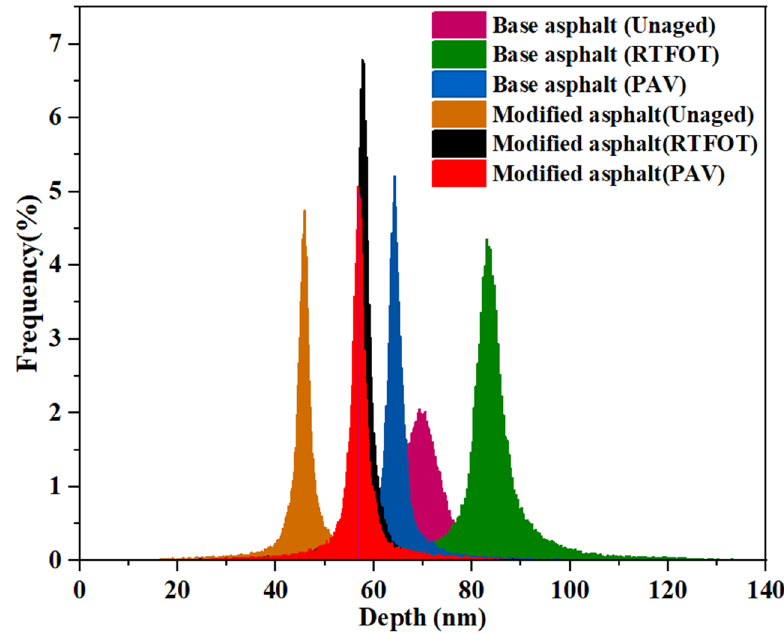
Figure 6. Height distribution of asphalt